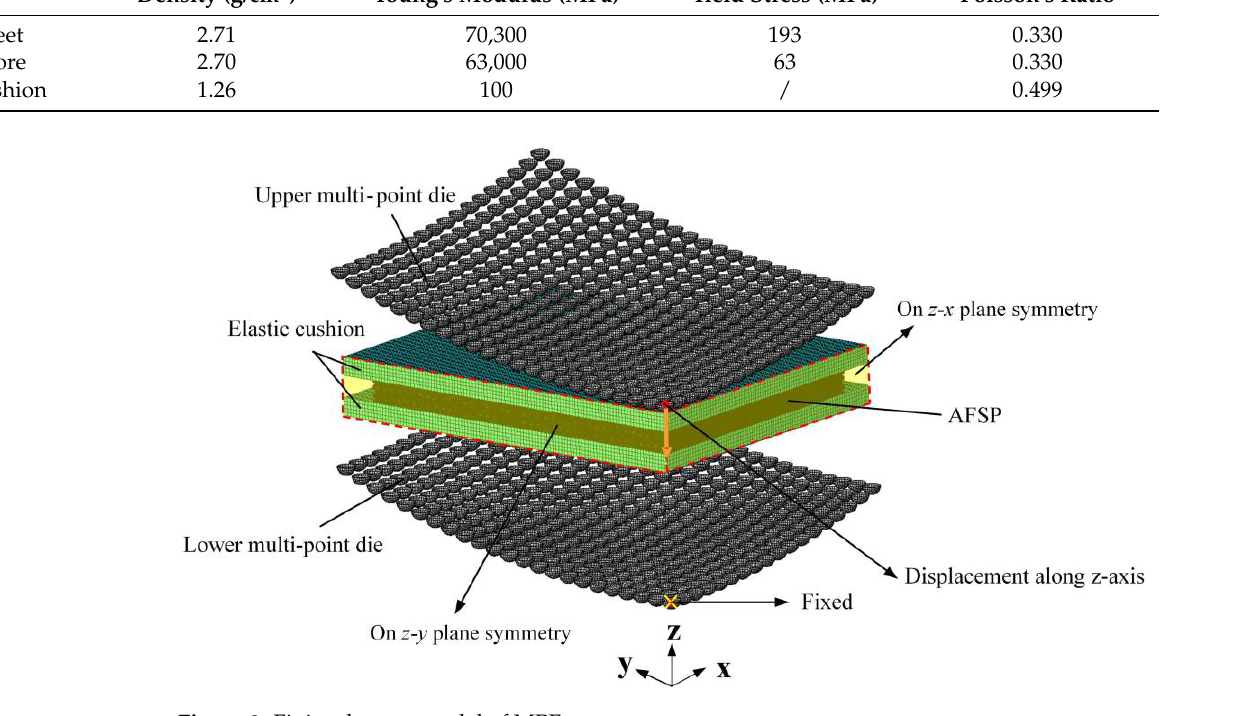
Figure 2. Finite element model of MPF. Table 2. Material parameters of AFSP and elastic